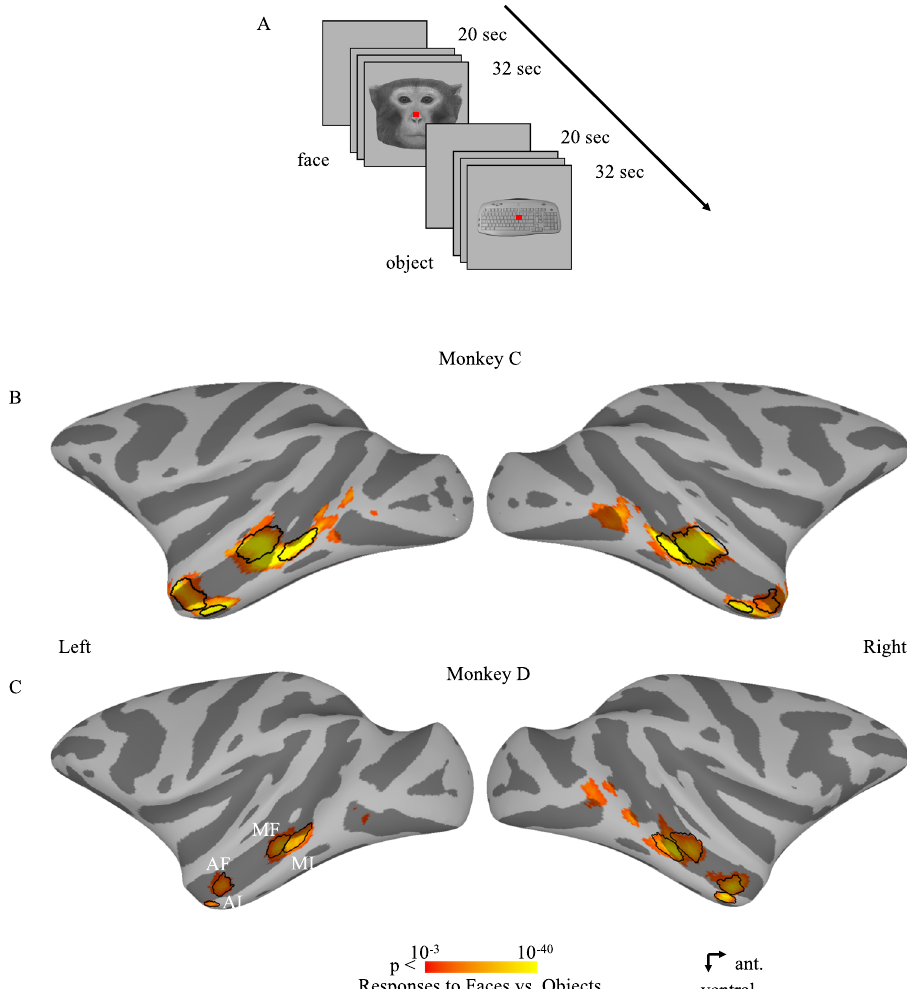
Fig. 1 | The fMRI experiment design and face-selective patches in Monkeys C andD.A AnillustrativeexampleofthefMRIexperimentdesign. B , C Face-selective (neutral monkey faces versus familiar objects, p <0.005 uncorrected) activation maps from the initial localizer sessions are shown on lateral views of the in fl ated